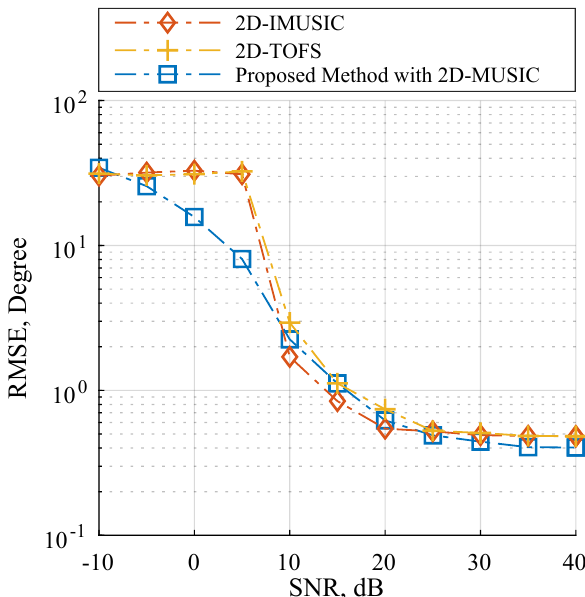
Figure 6. RMSE estimation performance versus SNR on Scenario 3 where M = 8.